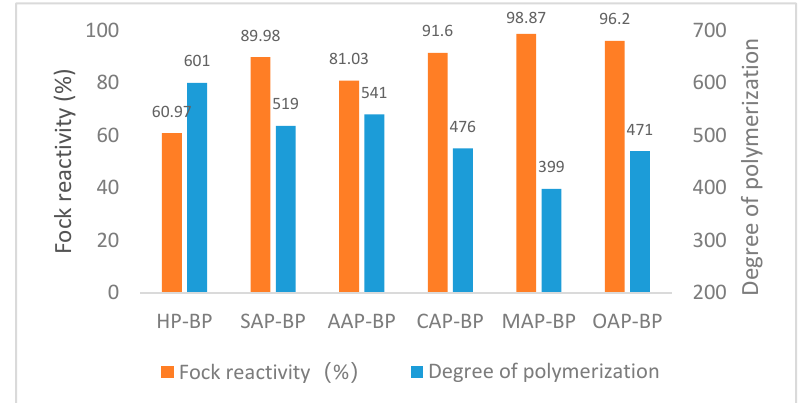
Figure 4. Fock reactivity and degree of polymerization of different dissolving pulps. BP means dissolving pulp after bleaching, SAP means sulfuric acid pretreatment, AAP indicates acetic acid pretreatment, while CAP represents citric acid pretreatment, MAP means maleic acid pretreatment and OAP implies oxalic acid pretreatment.